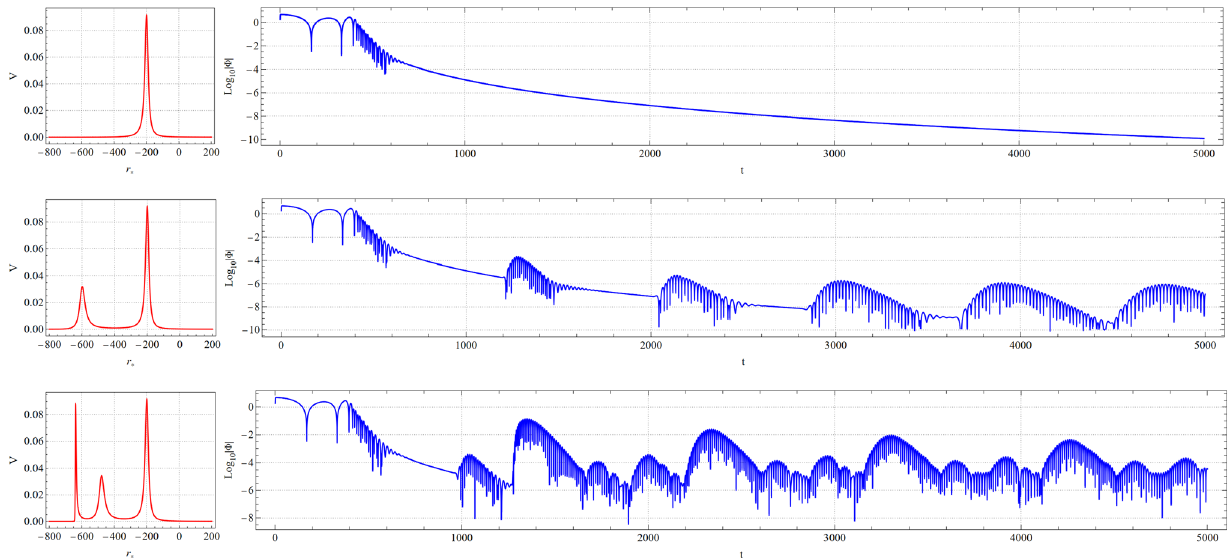
Fig. 2 The effective potential as a function of r ∗ and its corresponding time-domain profile. The parameters of each panel is corresponding to Fig. 1